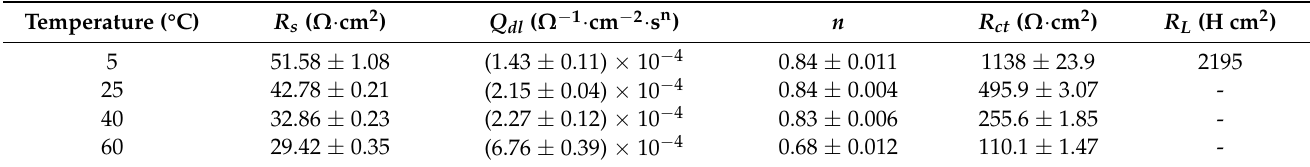
Figure 6. EIS results of AlCoCrFeNi 2.1 in chloride-containing sulfuric acid solution at different temperatures, ( a ) Nquist map; ( b ) Bode map; ( c ) Phase map; ( d ) Fitting results of R ct ; ( e ) the equivalent electrical circuit at 5 ◦ C; ( f ) the equivalent electrical circuit at 25 ◦ C, 40 ◦ C, and 60 ◦ C. Table 1. EIS fitting results of AlCoCrFeNi 2.1 in the test solution.